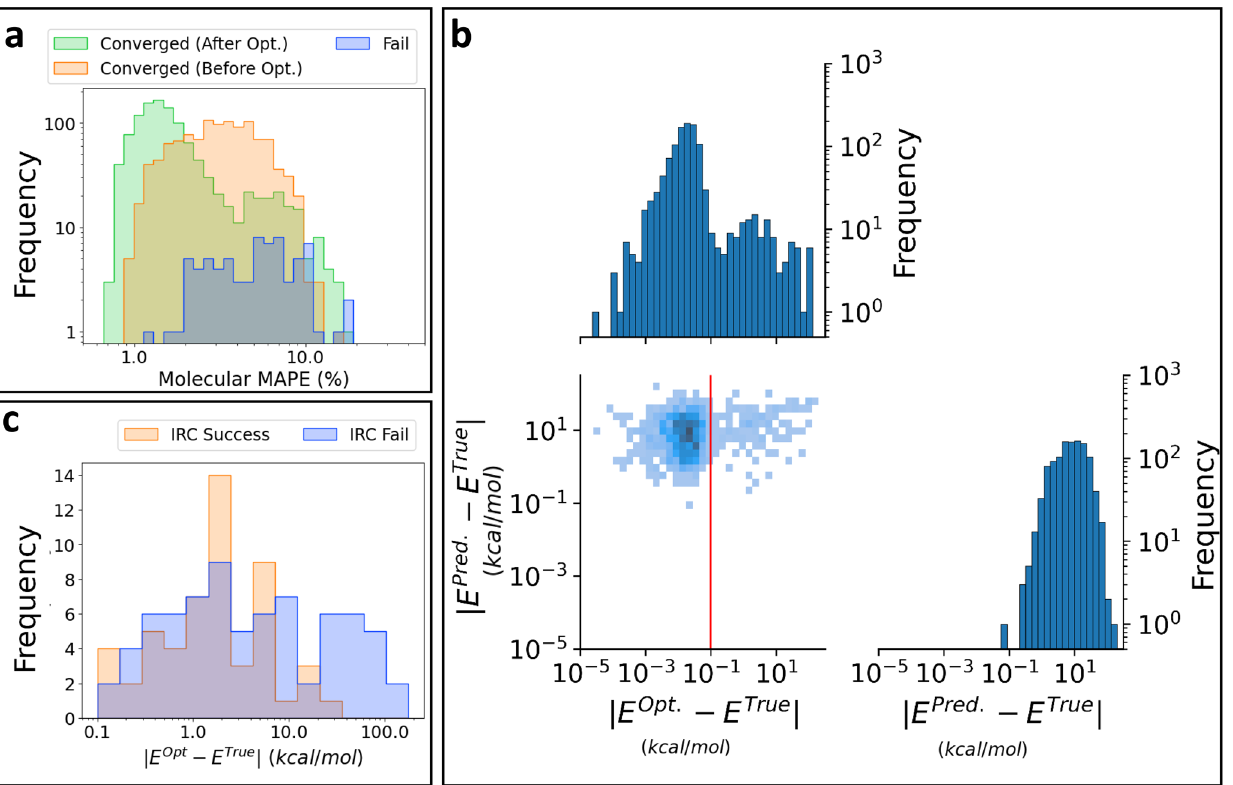
b Distributionsofabsoluteenergyerrorsofinferredandoptimizedstructures.The red line represents an absolute energy error of 0.1kcalmol − 1 . Intrinsic reaction coordinate(IRC)calculationswereperformedforthestructuresontherightsideof the red bar (126 cases). c Distributions of absolute energy errors of structures whose reference products and reactant structures were acquired (orange) or not acquired (blue) through IRC